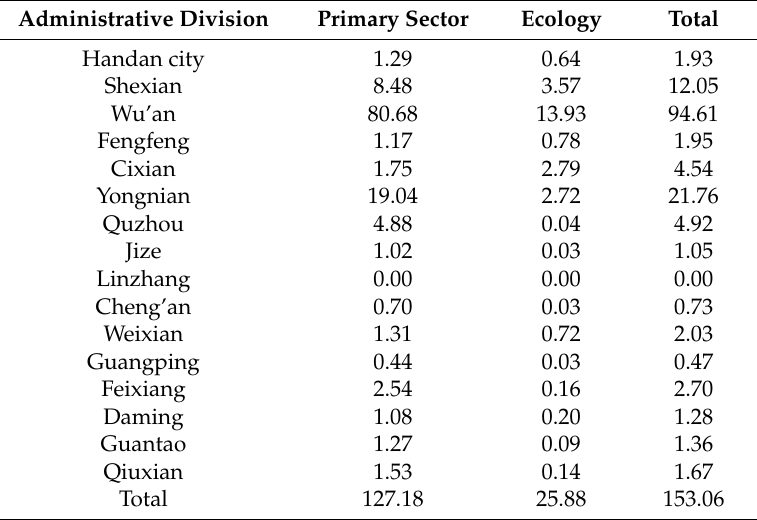
Table 5. Results for local surface water allocated to every user (10 6 m 3 ).